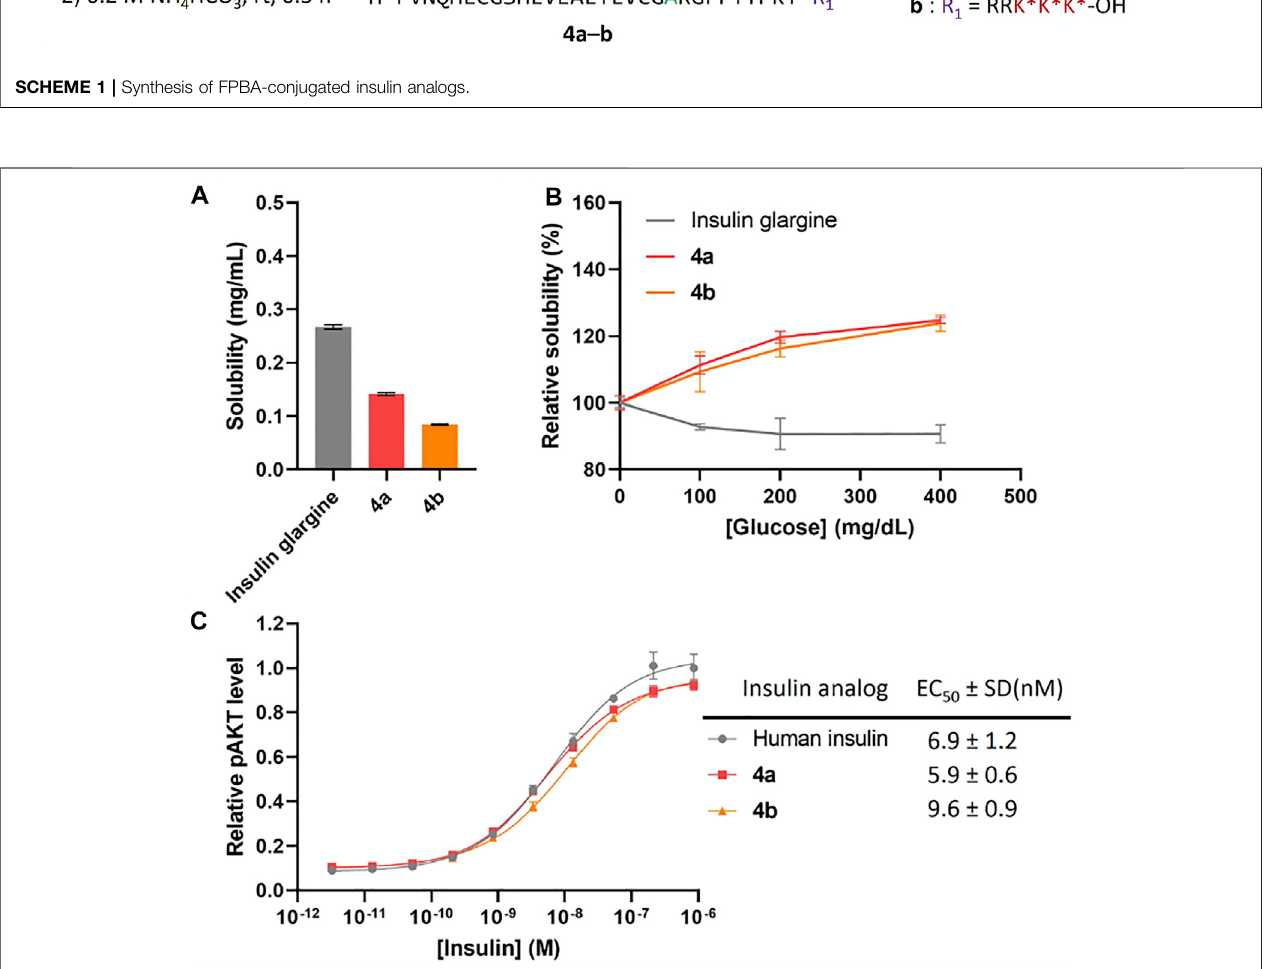
FIGURE 2 | (A) Solubility of insulin analogs in pH 7.4 PBS. Data are expressed as mean ± SD ( n = 4 per group). (B) Solubility of insulin analogs in pH 7.4 PBS with different glucose concentrations. Data are expressed as mean ± SD ( n = 4 per group). (C) In vitro activity of insulin analogs by using activated pAKT levels as measurements. Data are expressed as mean ± SD ( n = 4 per group). EC 50 was calculated by Prism 9 (GraphPad Software, CA, United States) with nonlinear regression curve fi tting of dose-response asymmetric equation.